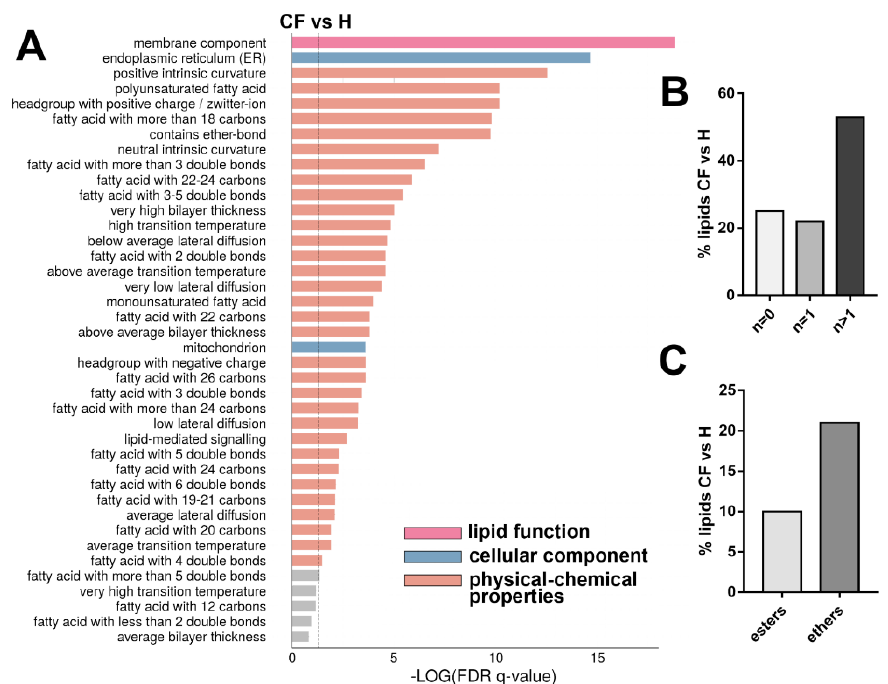
Figure 5. (A) Enrichment analysis (top 40) of CF vs. H phenotypes. The dotted line indicates the cut-off value of significant enrichments ( q < 0.05). Bar length is related with the enrichment ( − log q-values corrected for false discovery rate, FDR), whereas colors are dependent to the type of the enrichment: lipid function, cellular component, and physical-chemical properties. ( B ) Distribution of the acyl chain unsaturation from all lipid fraction (%) in CF vs. H discriminant lipid group (top 100). ( C ) Distribution of the ester and ether linkages in phospholipids (%) in CF vs. H in the discriminant lipid group (top 100). In ( B ) the chi-square test and in ( C ) binomial test, revealed a p -value < 0.05.